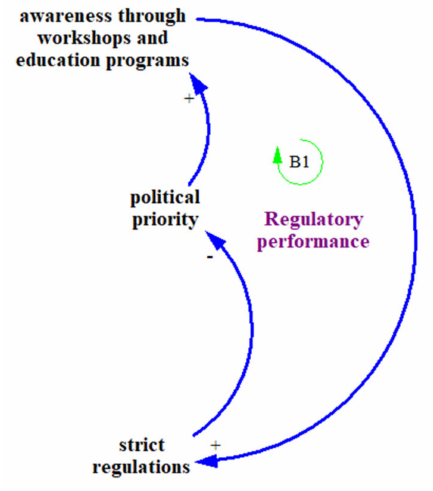
Figure 5. Balancing Loop B1.